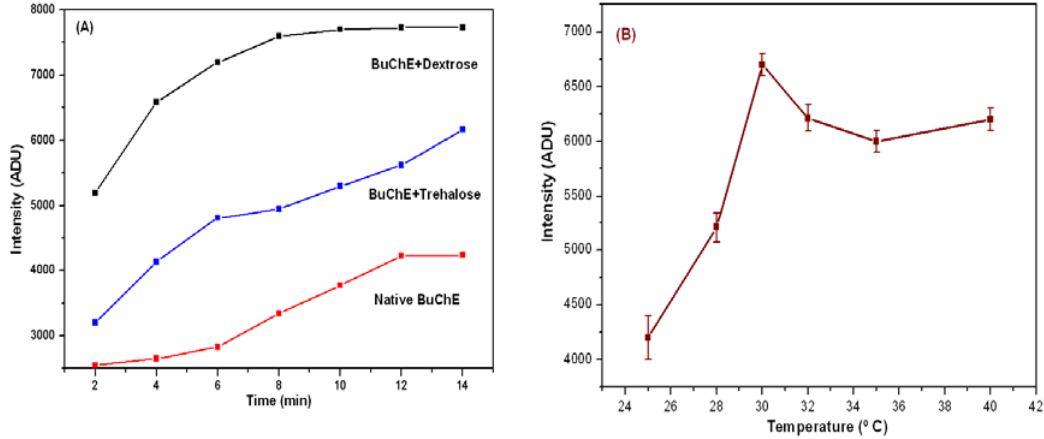
Figure 1. The Figure marked by (A) is CL intensity profile for native BuChE and stabilized BuChE with trehalose and dextrose in protein standard solution; the Figure marked by (B) shows Effect of temperature on the CL intensity of the stabilized BuChE in micro well plate with 0.5 mM BuChCl, 0.1 M PB, pH 7.4.